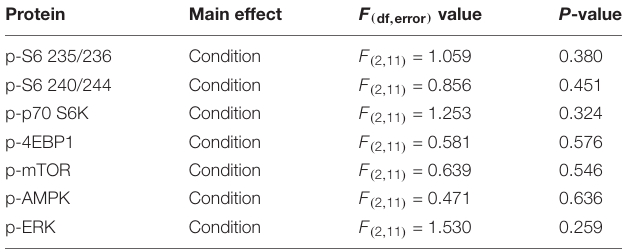
TABLE 3 | ANOVA results for western blots.